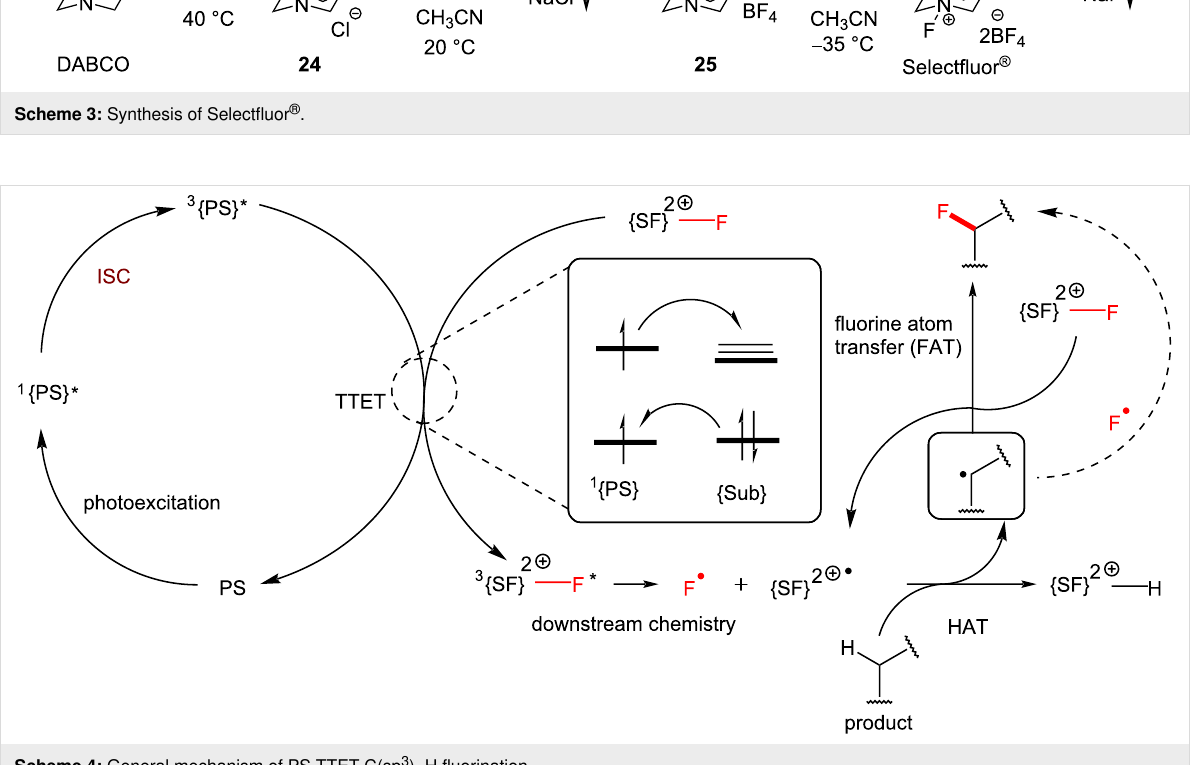
Scheme 4: General mechanism of PS TTET C(sp 3 )–H